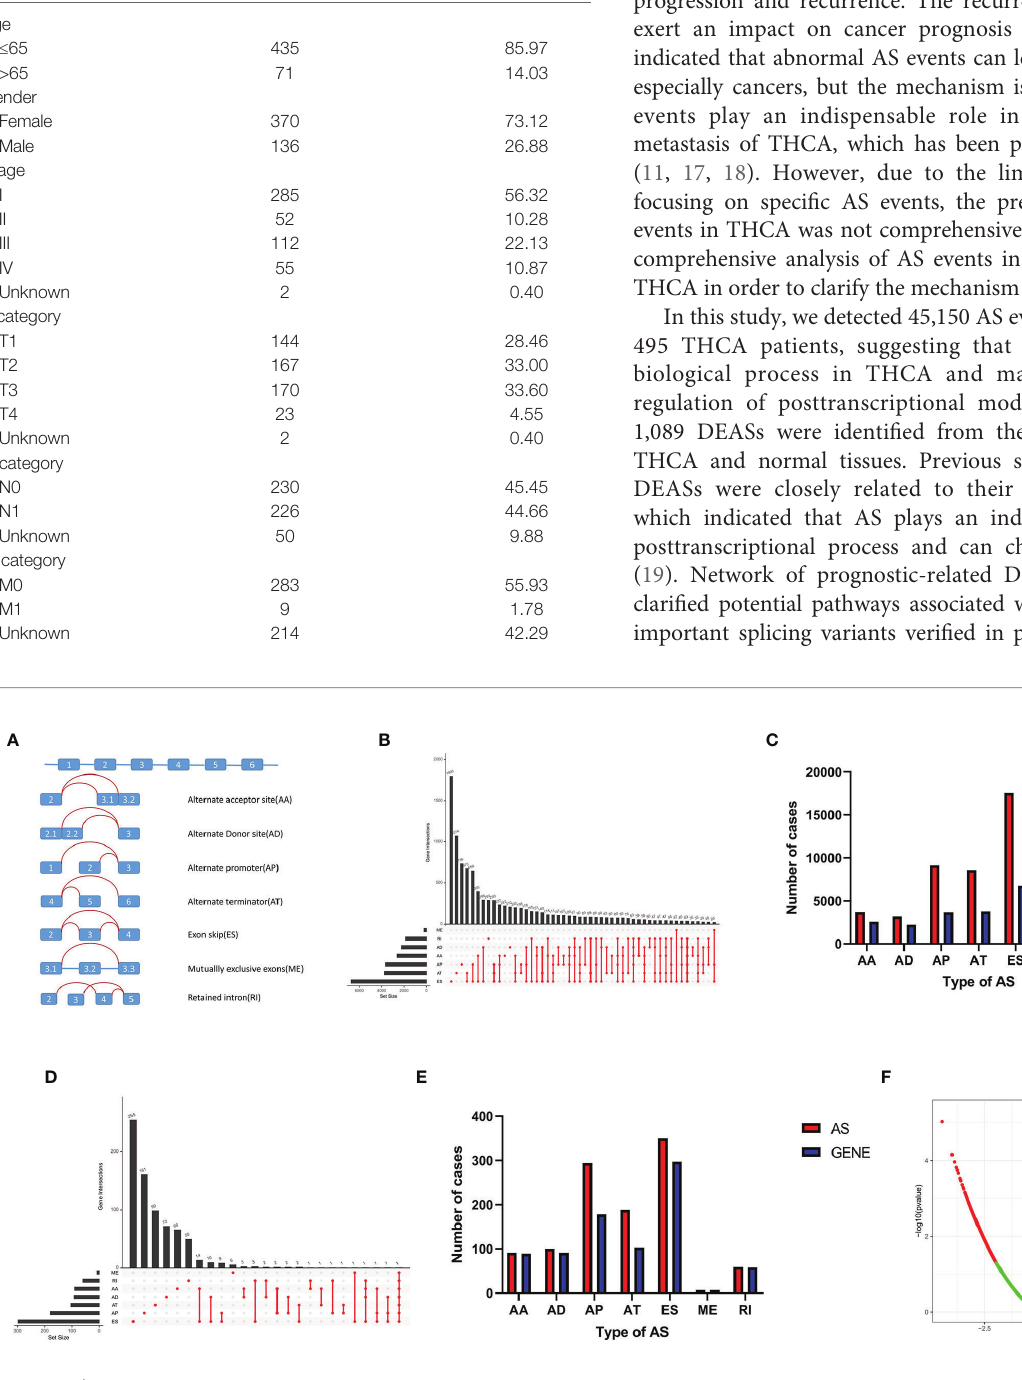
FIGURE 2 | AS events in THCA. (A) Seven AS events types. (B) Upset plot of seven types of AS events and related genes in THCA. (C) Bar plot of AS events and related gene numbers in THCA. (D) Upset plot of OS-related AS events and related genes. (E) Bar plot of OS-related AS events and related genes numbers. (F) Volcano plot of prognostic AS